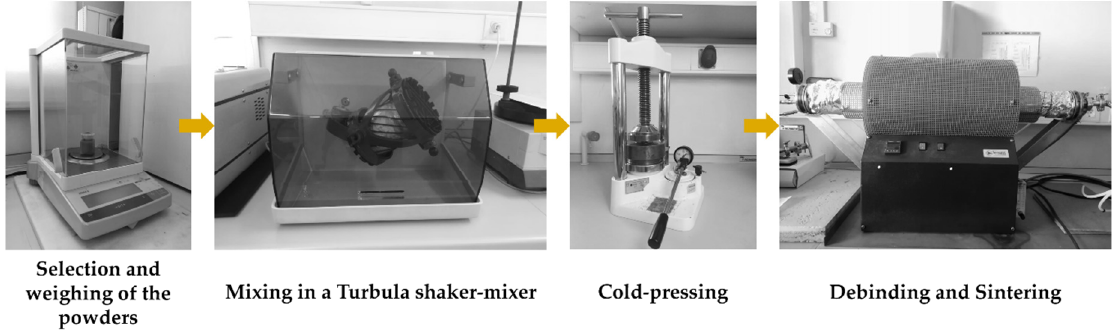
Figure 1. Fabrication steps for the Fe–WC inserts production.